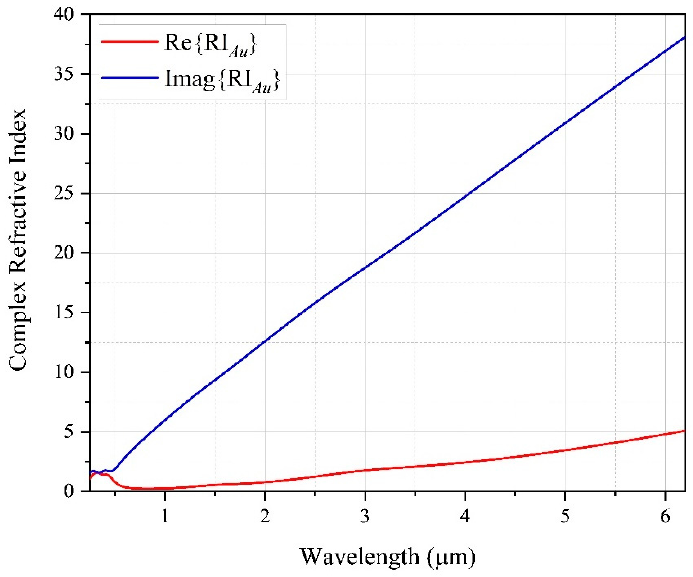
Figure 2. Real and imaginary part of the gold RI, for the wavelength range between 0.24797 μm and 6.1992 μm .